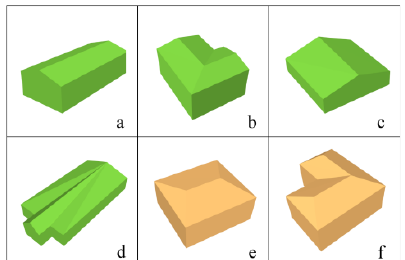
Figure 14. 3D building models for (a) rectangular gable, (b) l- shaped gable, (c) irregular pentagon gable, (d) irregular gable, (e) rectangular hipped, and (f) l-shaped hipped.